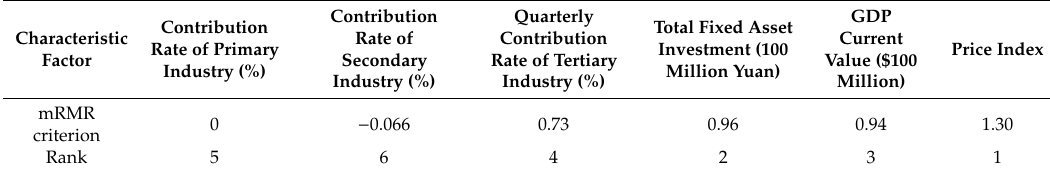
Table 5. mRMR calculation results of total load demand.